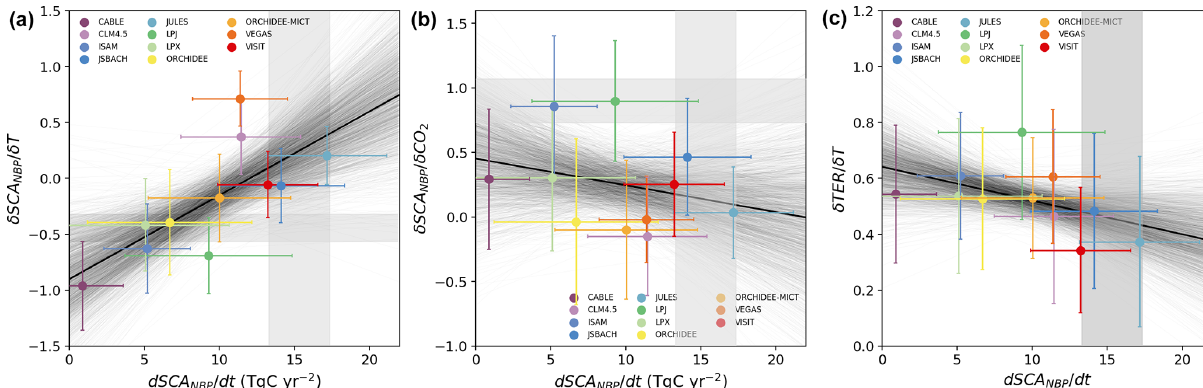
Figure 4. Emerging relationships between LSM sensitivities to climate and CO 2 and their SCA NBP trends. The SCA NBP trend for L > 40N estimated by each inversion (grey intervals) and corresponding responses of SCA NBP to (a) T and (b) CO 2 (as calculated in Fig. 3 but considering the scores of the regression only; shown in Fig. S5) are compared to the results from individual models (simulation S3; coloured markers). In (c) the SCA NBP trend for L > 40N estimated by individual models is compared with the simulated sensitivity of TER to T . The shaded areas indicate the inversion ranges, and the distribution of the grey lines shows uncertainty in the relationship between each pair of